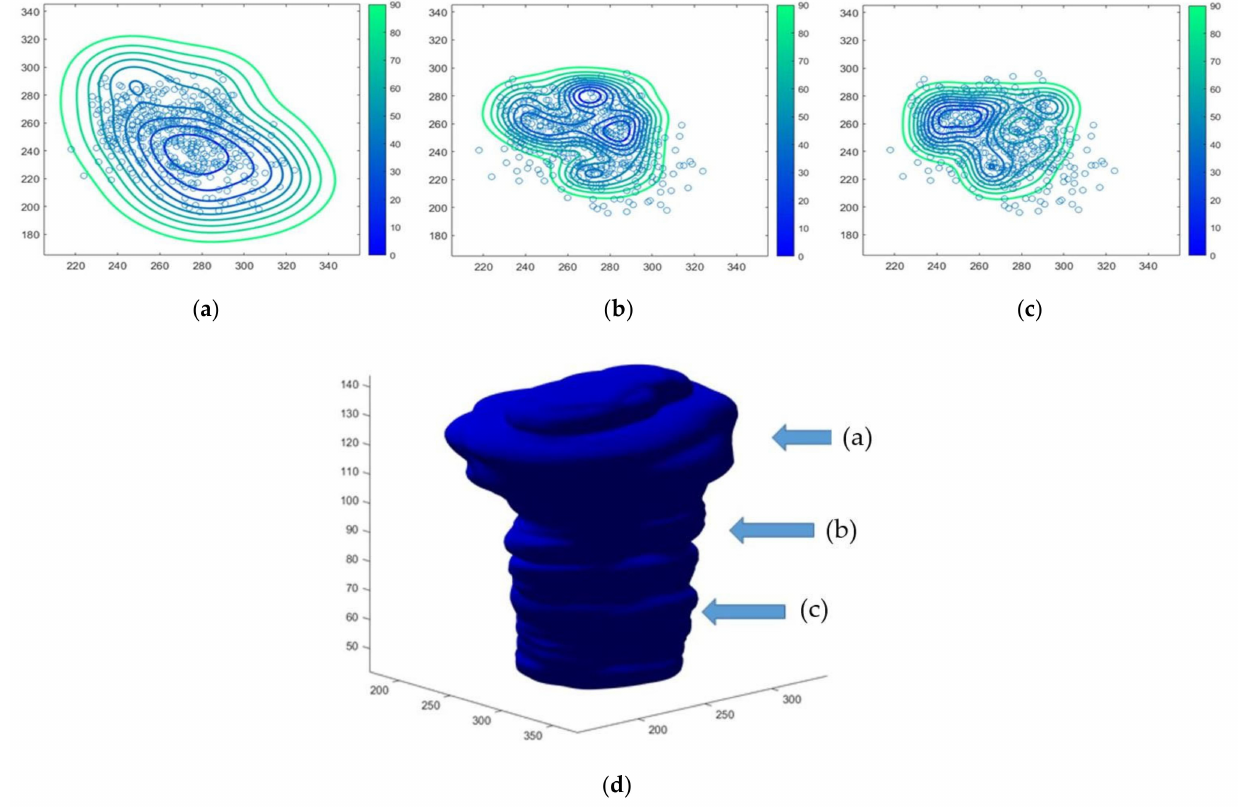
Figure 4. Three representative examples ( a , b , c ) of the iso-level local failures probabilistic density in the noxel space at the height are indicated by the corresponding raw indicated in ( d ). Open symbols represent the recurrence points randomly generated using RTOG 0848 CTV and experimental recurrence database. The 3D CTV80 corresponds to an 80% iso-level risk ( d